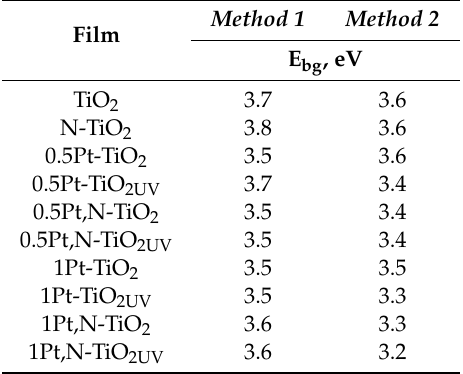
Table 1. Bandgap energy values of titania for indirect transition obtained from absorption spectra.